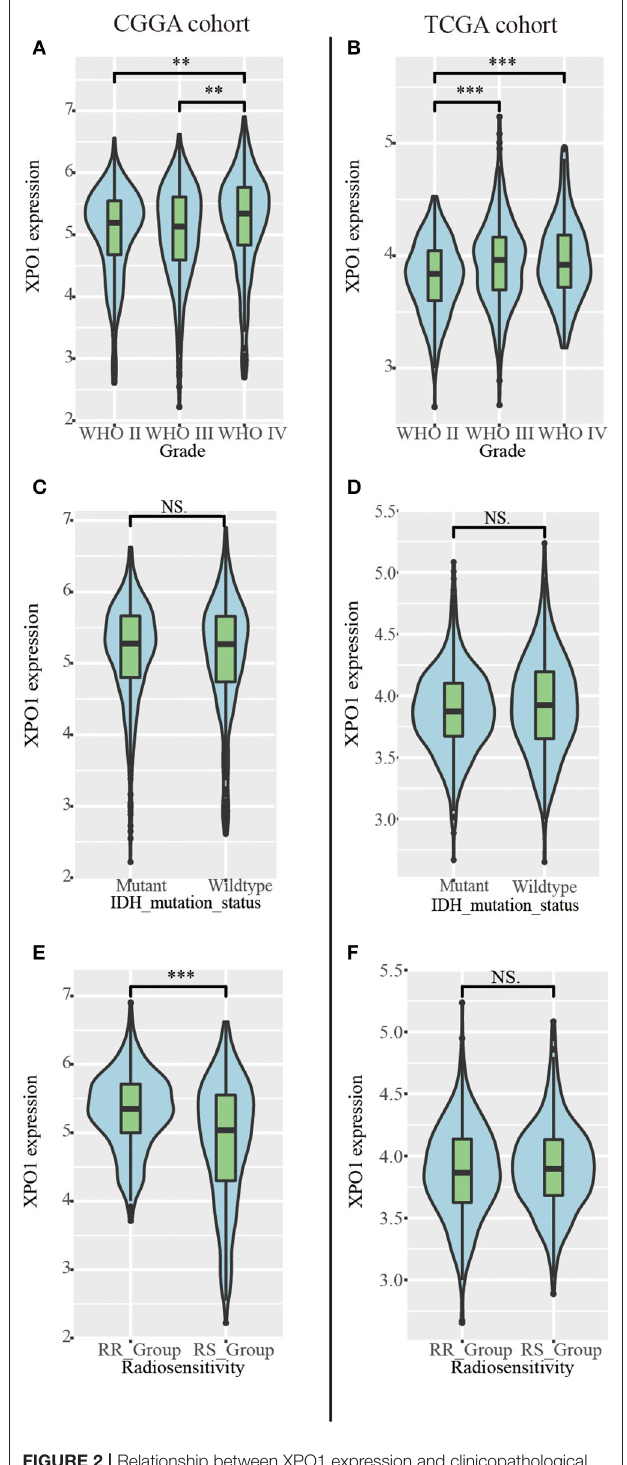
FIGURE 2 | Relationship between XPO1 expression and clinicopathological features. Association between XPO1 expression and different subgroups stratified by WHO classification (A,B) , IDH mutant status (C,D) , and radiosensitivity status (E,F) in the CGGA and TCGA cohorts (* P < 0.05, ** P < 0.01, **** P < 0.0001, NS P ≥